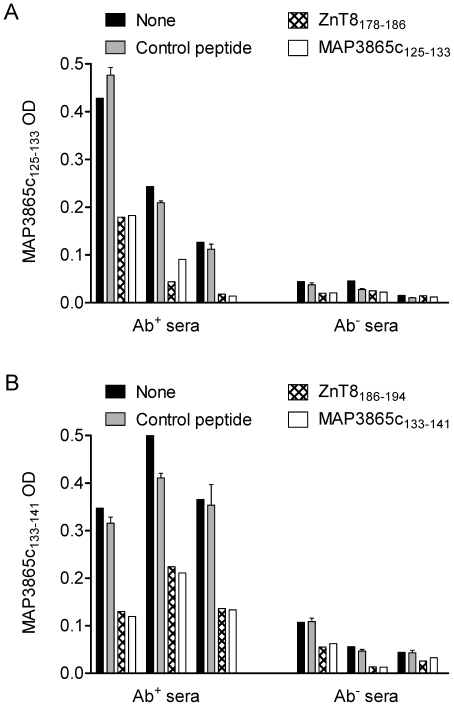
Ab reactivities against MAP3865c epitopes are inhibited by the homologous ZnT8 epitopes.(A) Ab+ and Ab-negative sera from T1D patients were pre-incubated overnight with saturating concentrations of MAP3865c125–133 (white bars), ZnT8178–186 (hatched bars), control (grey bars) or no peptide (black bars) and their reactivity on MAP3865c125–133-coated ELISA plates subsequently tested. (B) The same sera were preincubated with MAP3865c133–141 (white bars), ZnT8186–194 (hatched bars), control (grey bars) or no peptide (black bars) and their reactivity on MAP3865c133–141-coated ELISA plates subsequently tested. Bars depict means ± SEM of triplicate wells and results are representative of two separate experiments.